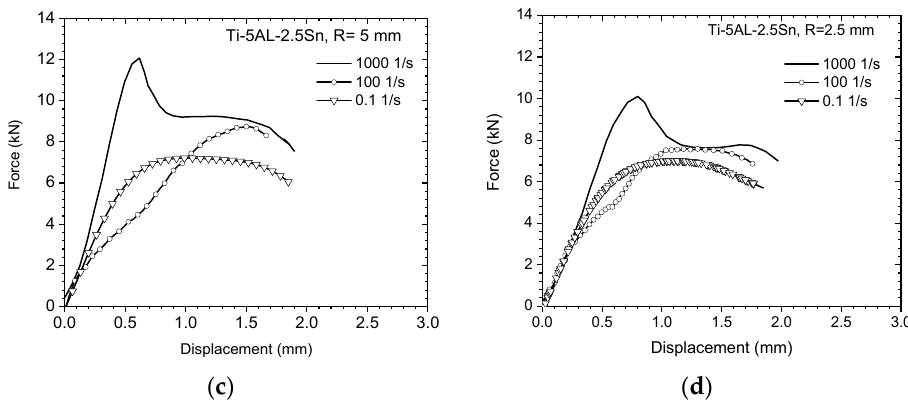
Figure 3. Force versus displacement of Ti ‐ 5Al ‐ 2.5Sn specimens under tension at strain rates of 0.1, 100, and 1000 s − 1 ; ( a ) specimens without notch; ( b ) specimens with notch radius R = 10 mm; ( c ) R = 5 mm; and ( d ) R = 2.5